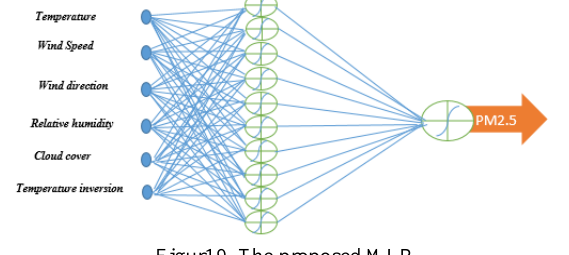
Figur19. The proposed